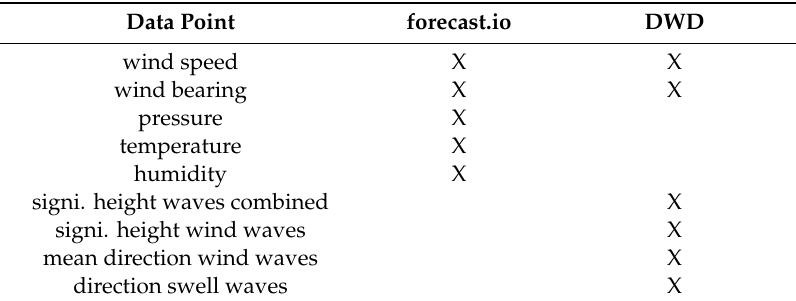
Table 1. Weather data